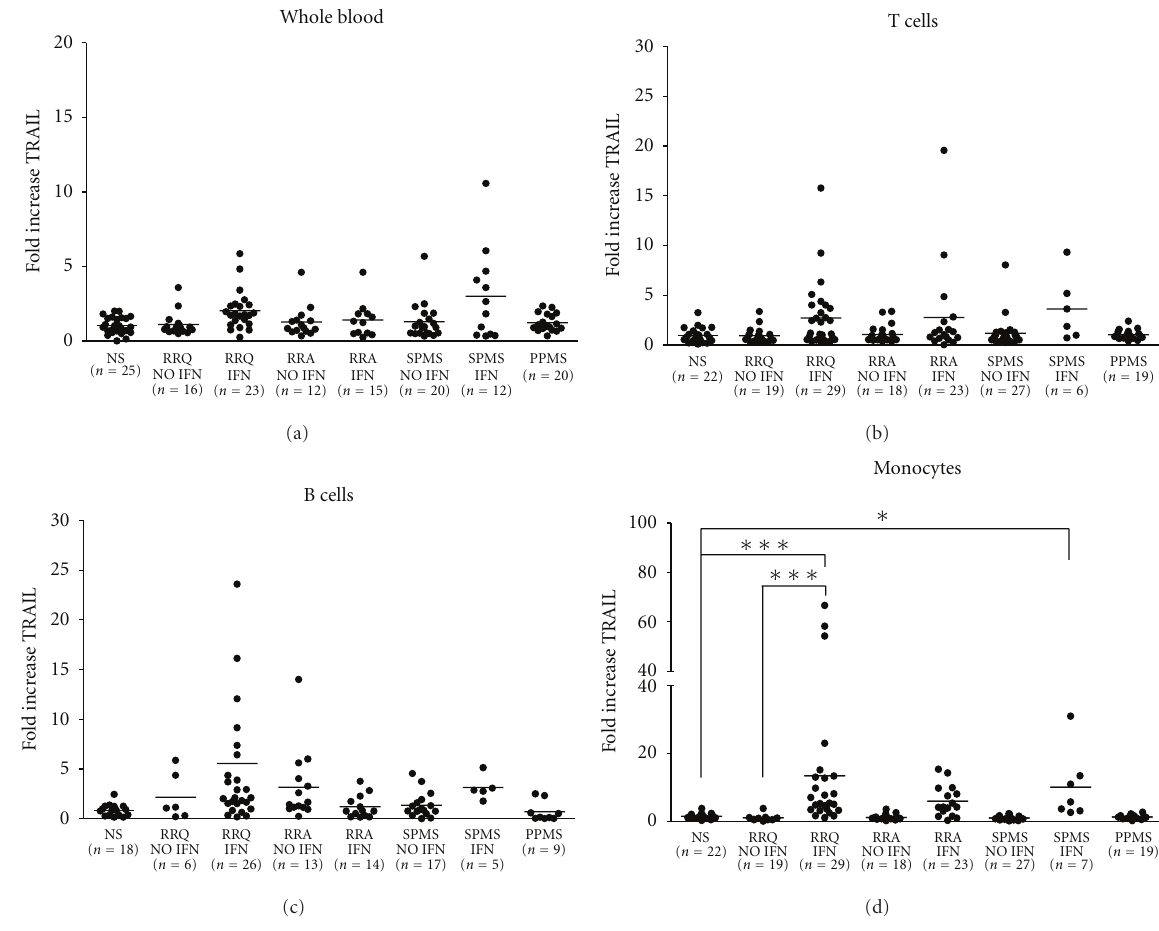
Figure 1: Relative quantification of TRAIL mRNA expression in RNA extracted from whole blood, T cells, B cells, and monocytes employing qRT-PCR. (a) In whole blood, TRAIL gene expression was no di ff erent between the various groups . (b) In T cells, TRAIL gene expression was also no di ff erent among NS and the various patient groups. (c) In B cells, TRAIL gene expression was the same in the various groups examined. (d) In monocytes, TRAIL gene expression was increased in RRQ IFN and SPMS IFN patients relative to NS. TRAIL mRNA was also elevated in RRQ IFN relative to RRQ NO IFN. ∗ P < . 05, ∗∗ P < . 01 and ∗∗∗ P < . 001, Dunn’s post hoc test.